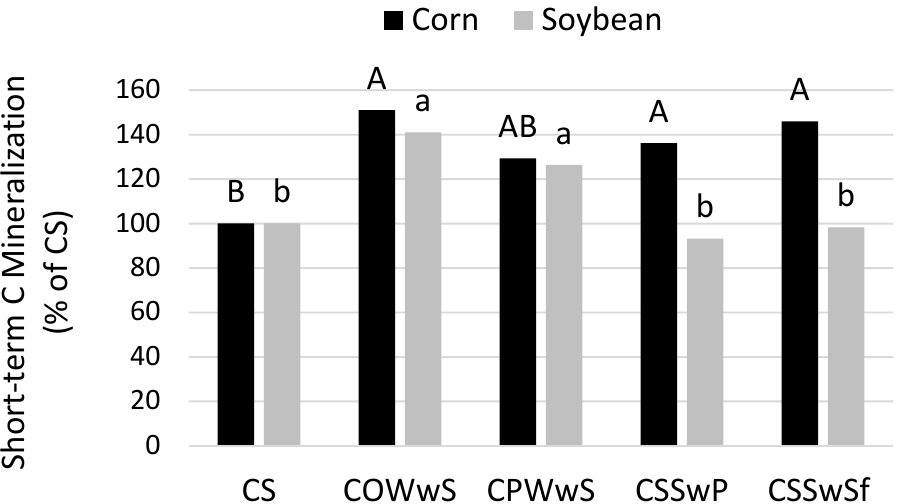
Figure 3. Short-term C mineralization in the 0–5 cm depth interval; values are means ( n = 4) for each crop rotation treatment expressed a percentage of the mean for the default corn–soybean rotation according to crop phase. CS, corn–soybean; COWwS, corn–oat–winter wheat–soybean; CPWwS, corn–field pea–winter wheat–soybean; CSSwP, corn–soybean–spring wheat–field pea; CSSwSf, corn–soybean–spring wheat–sunflower. Values marked with the same letter within the aggregate group are not different at α = 0.05, Tukey’s test.